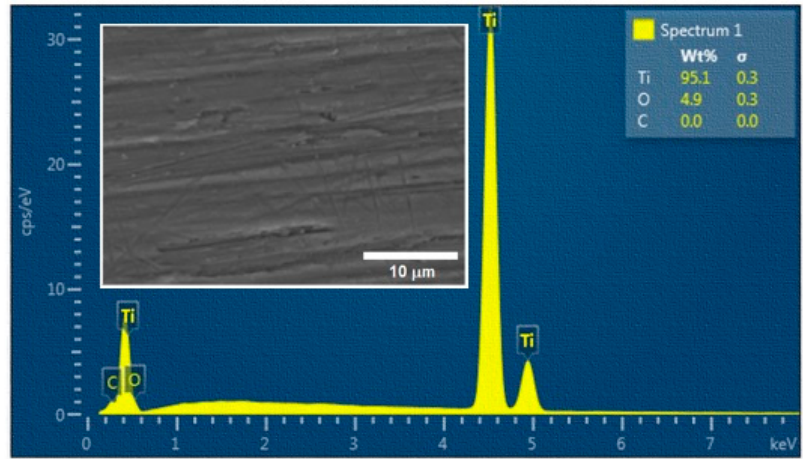
Figure 2. Result of energy dispersive X-Ray spectroscopy (EDS) analysis of a non-irradiated surface.